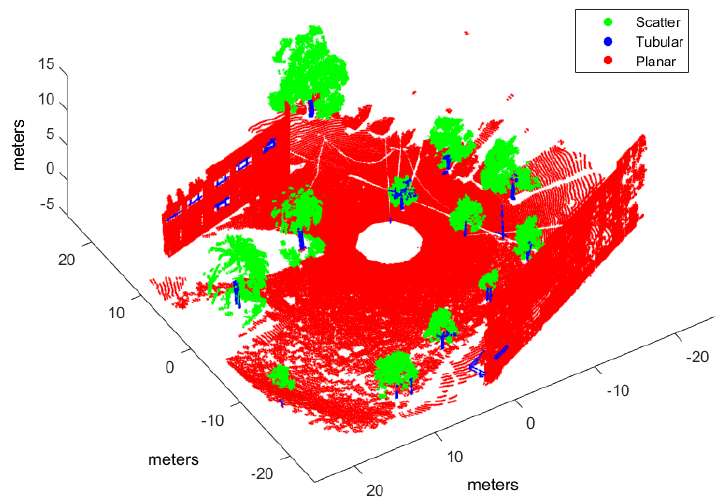
Figure 2. Hand labeled Urban point cloud.